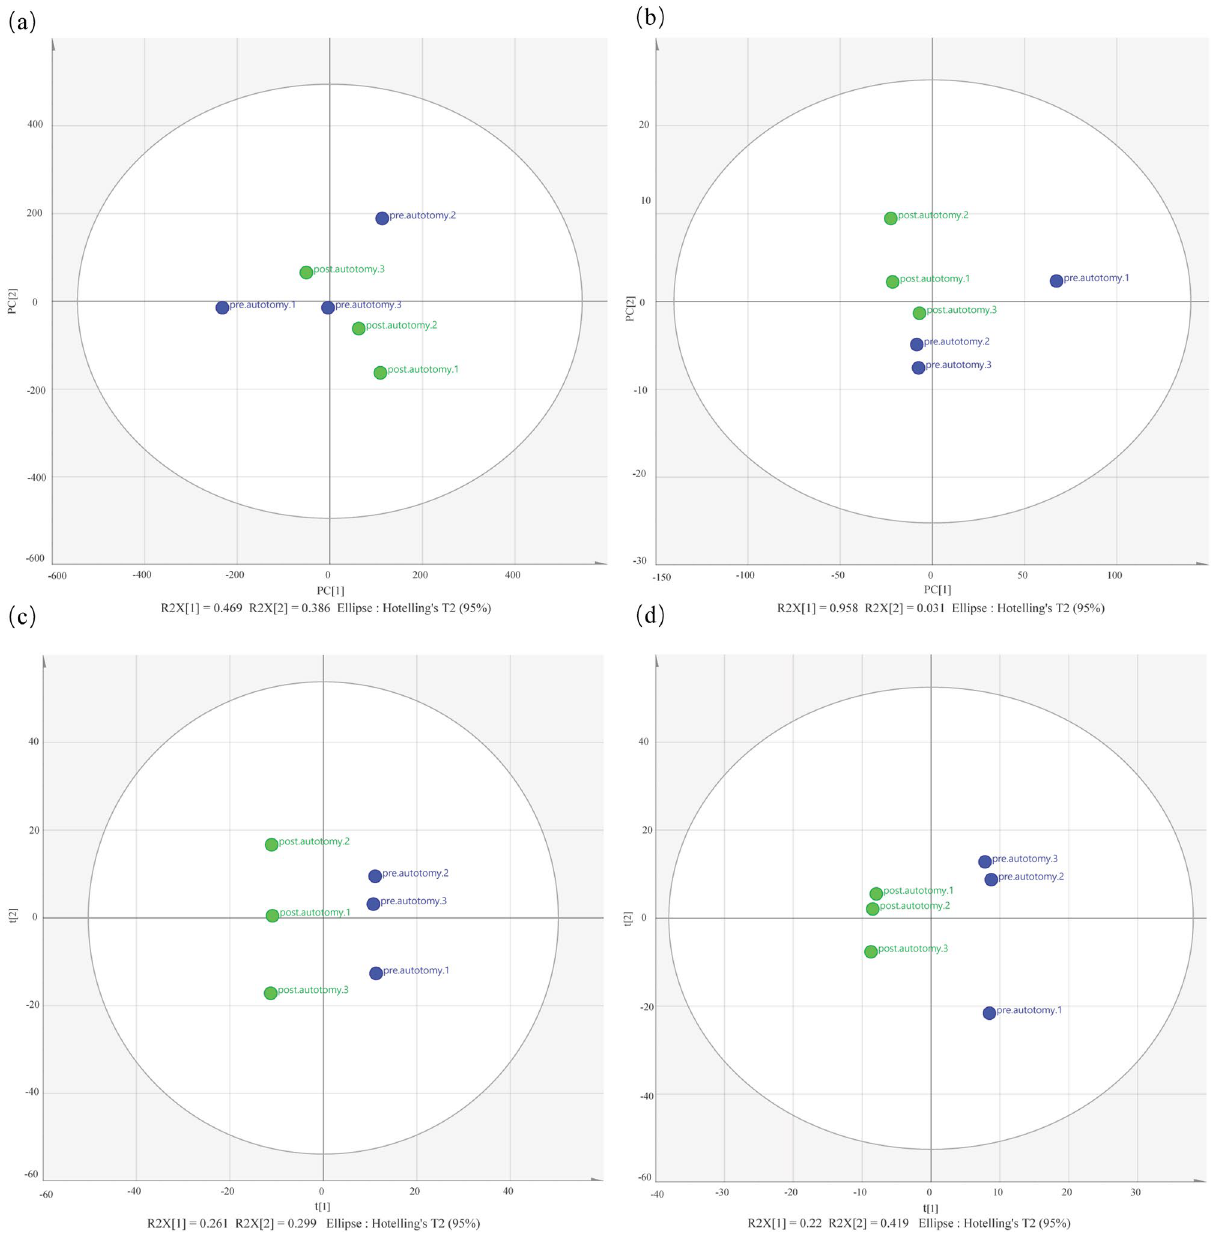
Figure 3. Principal component analysis (PCA) and orthogonal projections to latent structures–discriminant analysis (OPLS-DA) score plots in liquid chromatography tandem-mass spectrometry (LC–MS) metabolite profiles pre/post autotomy of the siphon in Solen grandis . ( a , b ) PCA score plots and ( c , d ) OPLS-DA score plots. Left ( a , c ): positive ion mode and right ( b , d ): negative ion